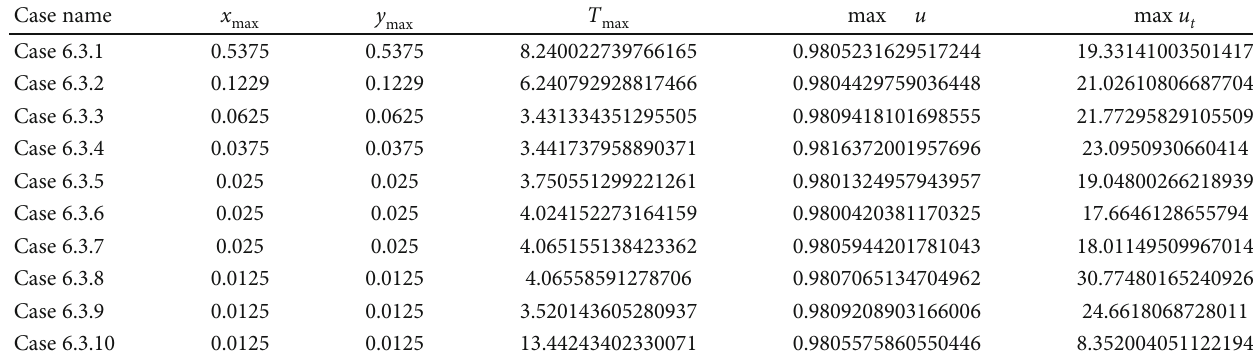
Table 9: Quenching data of α and β based on convection term b / ð α x + β y Þ